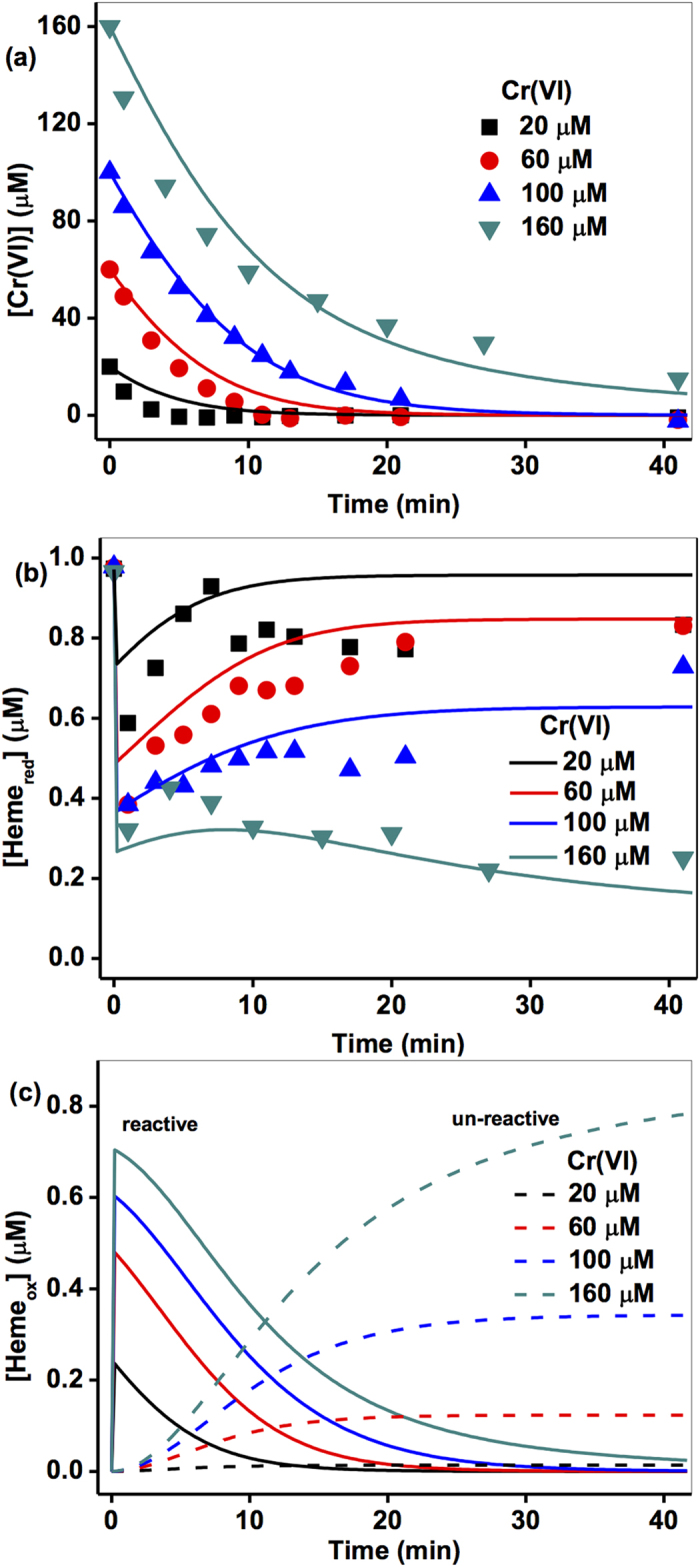
The kinetics of Cr(VI) reduction by c-Cyts in intact SP200 cell suspensions.(a) Cr(VI) reduction; (b) Hemered reduction. Cr(VI): 20 μM–160 μM mg L−1, SP200: 1.5 × 1011 cells mL−1. (c) The predicted concentrations of reactive Hemeox and un-reactive Hemeox. Solid lines represent the model fit using Eqs 2, 4 and 7 with rate constants k1 = 15.3 s−1, k2 = 7.68 × 104 M−1 s−1 and k3 = 56.7 M−1 s−1.